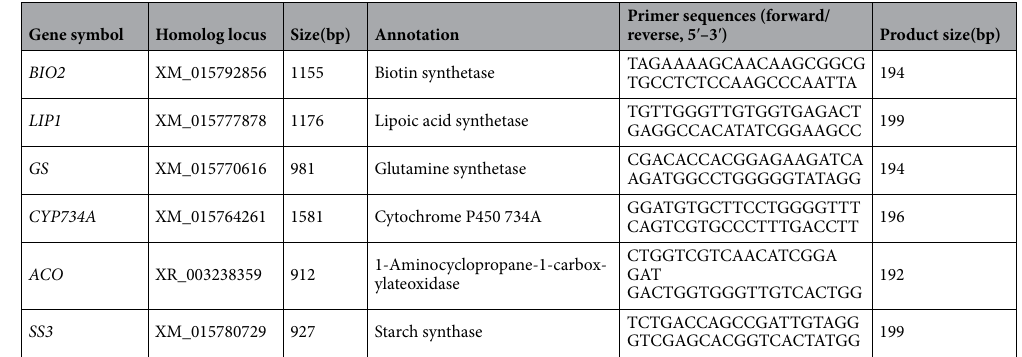
Table 3. Delineations of six differentially expressed genes in bulbil formation of P. ternata .